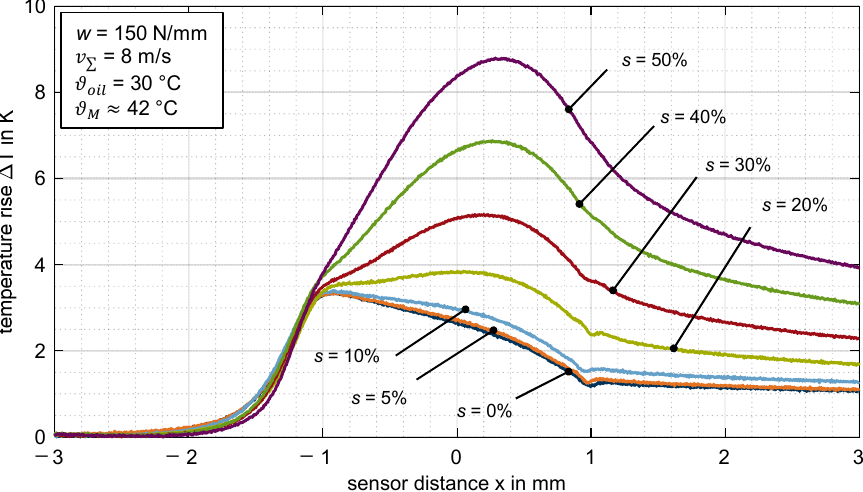
Figure 7. Measured temperature rise ∆ T T , pressure-induced correction temperature ∆ T p and pressure-corrected temperature rise ∆ T for the thermoplastic EHL contact ZrO 2 /PEEK (line load w = 150 N/mm, sum velocity v ∑ = 8 m/s, slip ratio s = 0%, oil temperature ϑ oil = 30 ◦ C, MIN100).